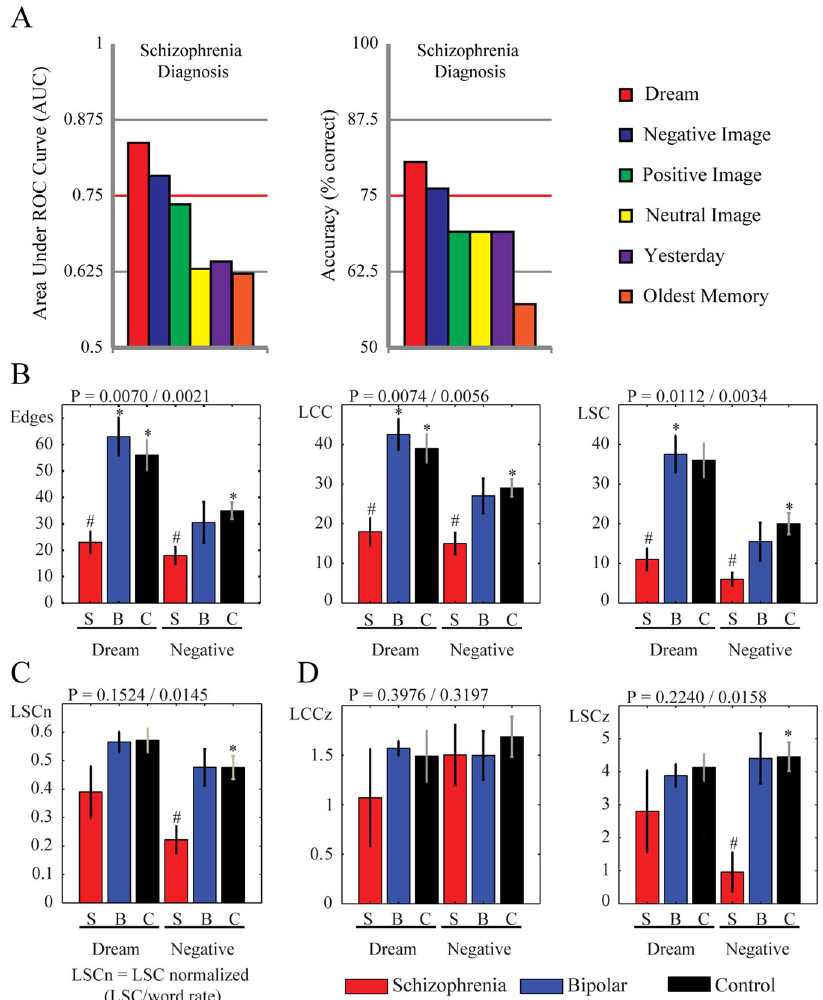
Fig. 3 Comparison of different methods for eliciting informative reports in terms of their discrimination performance for schizophrenia. Dream and Negative image reports are more discriminating than long-term memories. a Schizophrenia diagnostic classi fi cation using 5 connectedness attributes (E, LCC, LSC, LCCz, and LSCz) using 6 time-limited memory reports. Only dream and negative image reports classi fi ed schizophrenia group vs. Bipolar and Control group with AUC > 0.75 and accuracy > 75%. b Connectedness attributes from dream and negative image reports compared between groups. c LSC normalized by word rate from dream and negative image reports compared between groups d The z -scores of the original graph connectedness relative to the random graph distributions (LCCz and LSCz) from dream and negative image reports compared between groups. Bar plots indicate of median values and error bars indicate standard error of the mean (s.e.m); Kruskal – Wallis tests: p value for dream/negative image reports indicated in each title; Wilcoxon – Ranksum tests (Bonferroni corrected for 8 comparisons (4 comparison for each 2 memory reports — SxB, SxC, Sx(B + C), and BxC)): # means p < 0.0063 — Schizophrenia vs. Bipolar and Control groups, asterisk means p < 0.0063 — Schizophrenia vs. Bipolar or Control